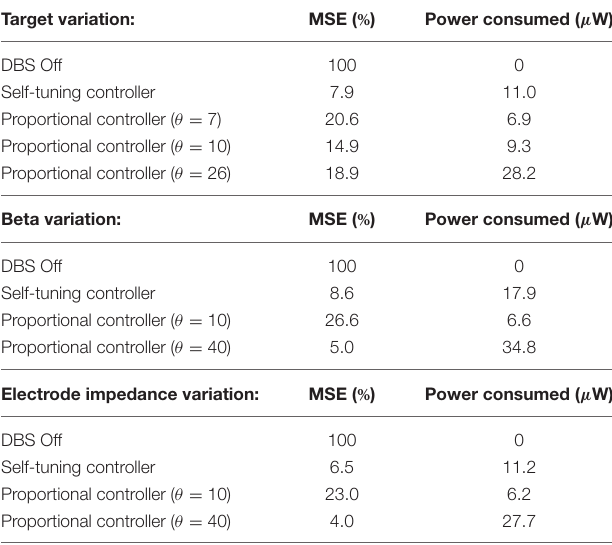
TABLE 2 | Summary of controller performance in the three considered